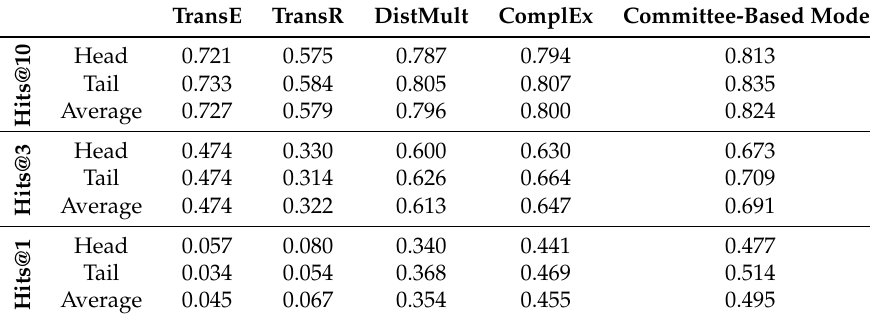
Table 5. Experimental results for WN18 data set.